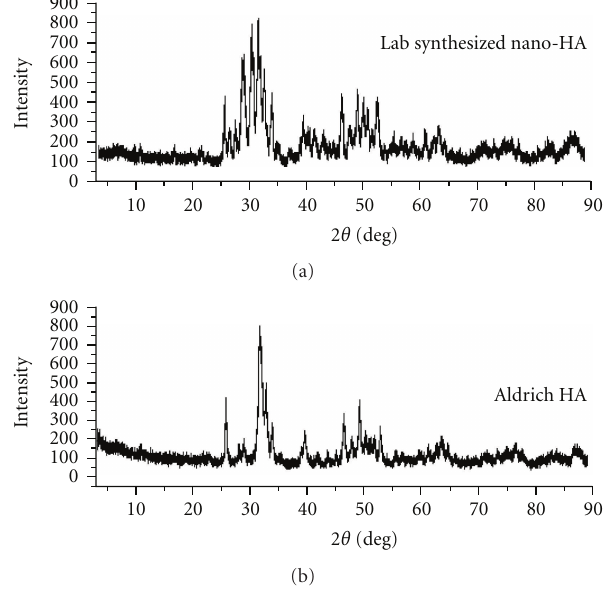
Figure 3: Lab synthesized nano-HA and Aldrich HA.